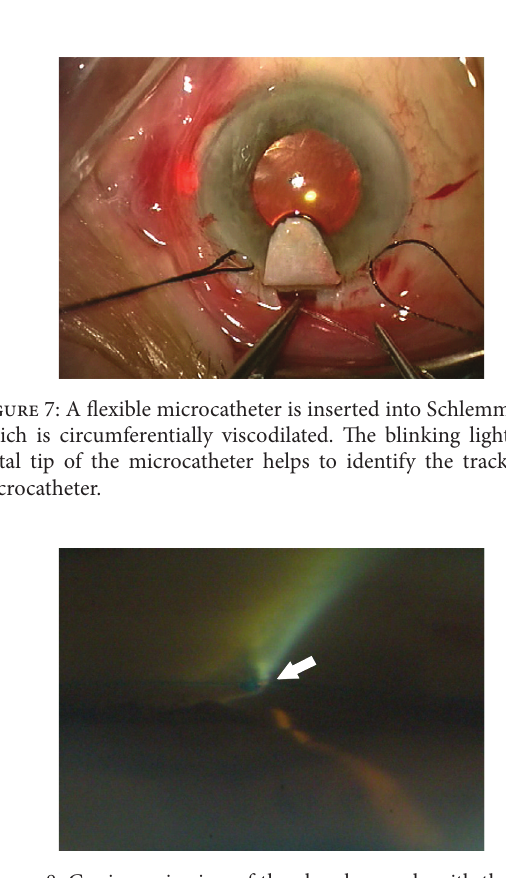
Figure 8: Gonioscopic view of the chamber angle with the suture stent pulling the inner wall of SC towards the anterior